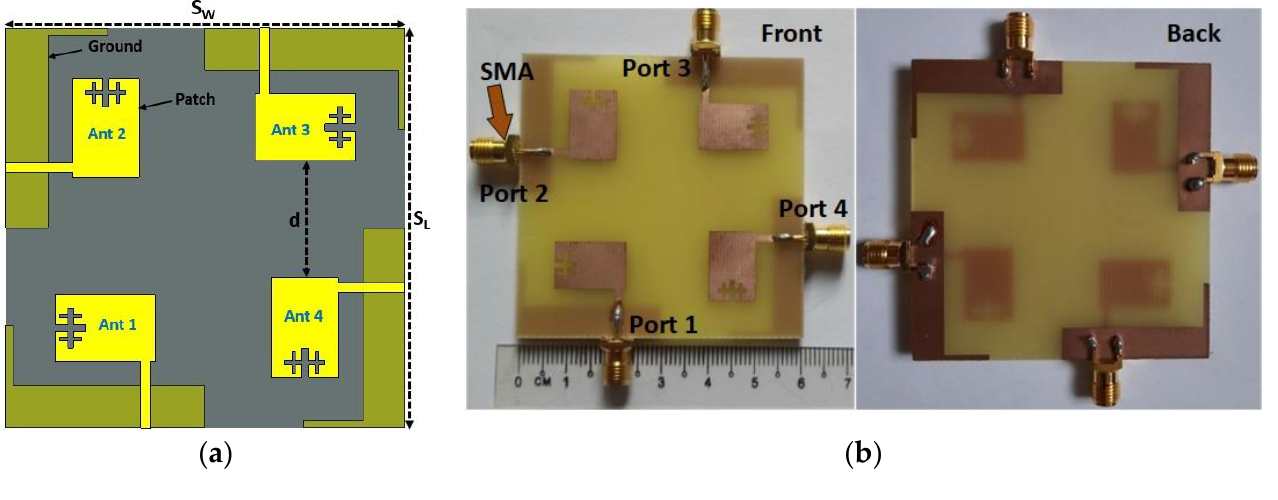
Figure 5. ( a ) Design architecture of the Wideband MIMO antenna ( S L , S W = 60 mm and d = 17.5 mm) and ( b ) fabricated 4-port MIMO antenna prototype.